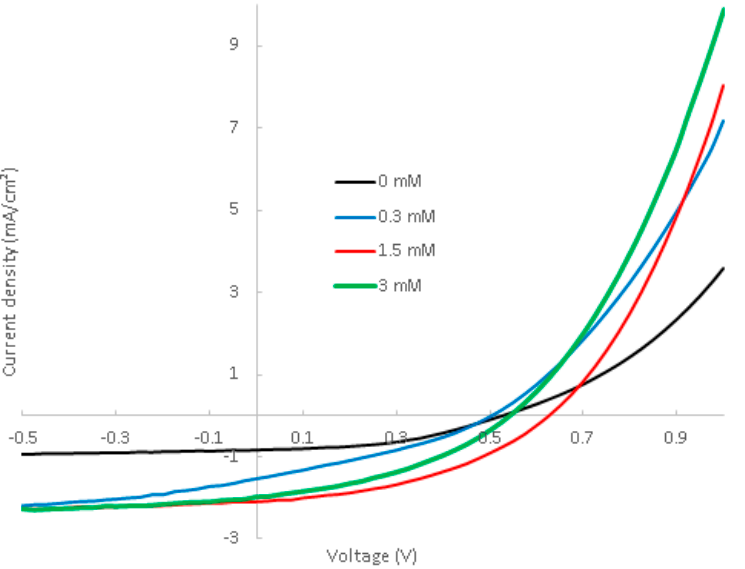
Figure 3. Current–voltage characteristics of solid-state dye sensitized solar cells (ssDSSCs) sensitized with dye M2 depending on the co-adsorbent concentration.